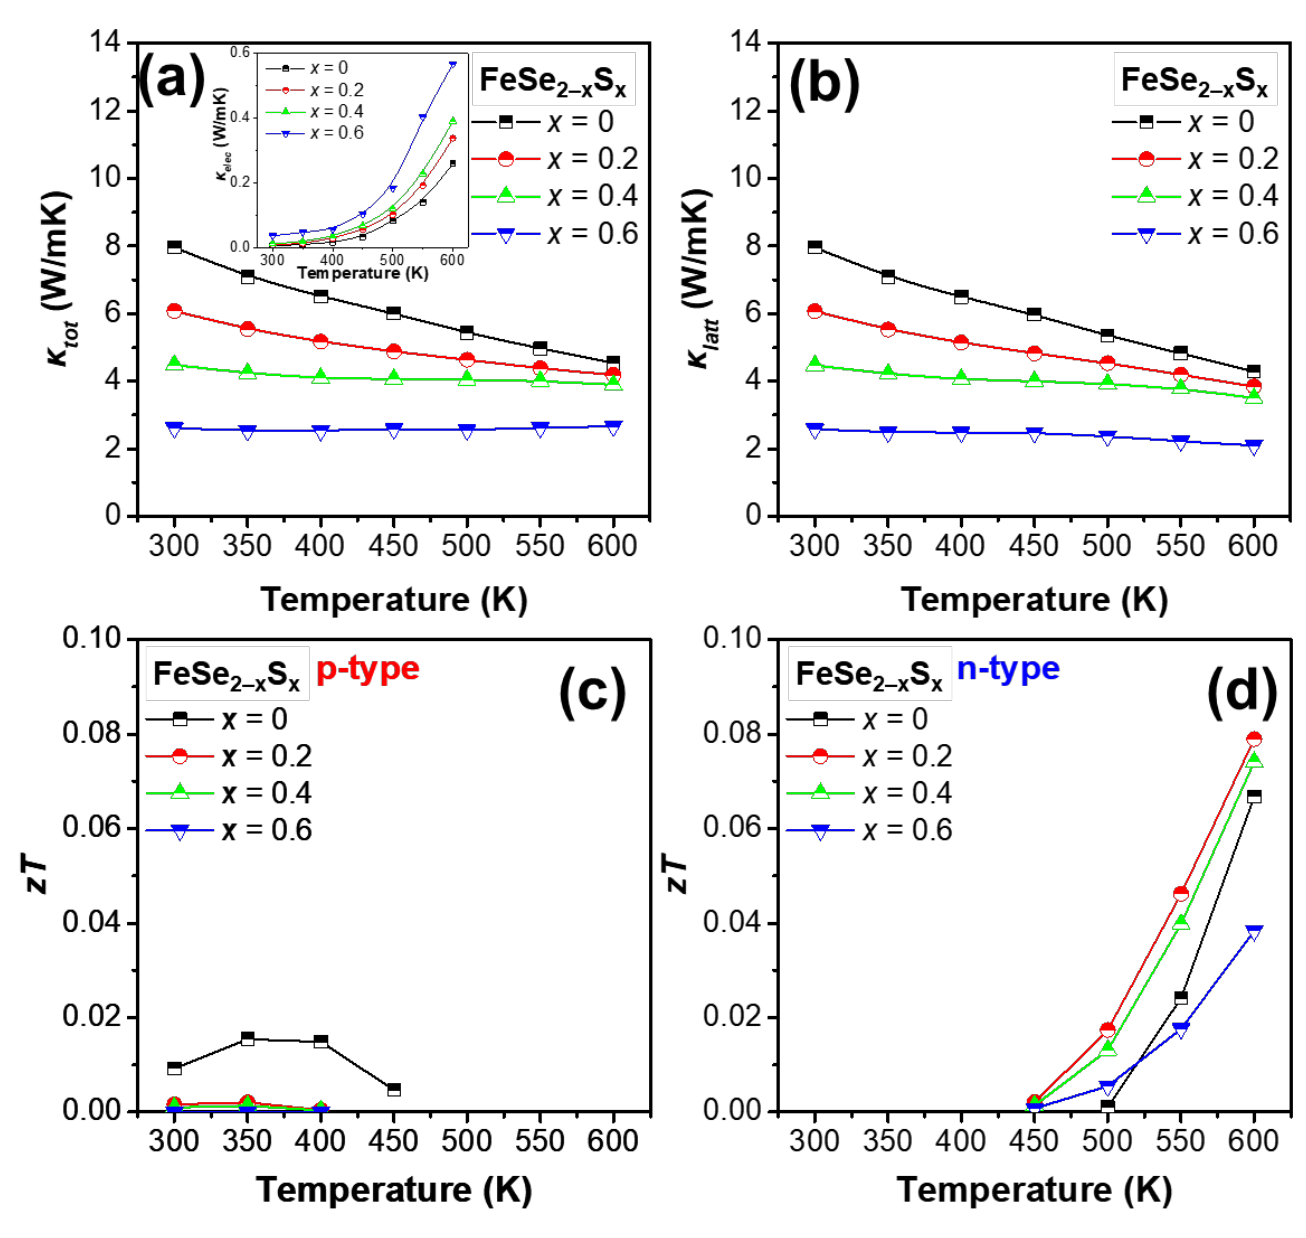
Figure 4. ( a ) κ tot and ( b ) κ latt as functions of temperature for the series of FeSe 2 − x S x ( x = 0, 0.2, 0.4, and 0.6) samples. The inset of ( a ) shows κ elec as a function of temperature for the samples. zT as a function of temperature for the samples in ( c ) p - and ( d ) n -type regions.